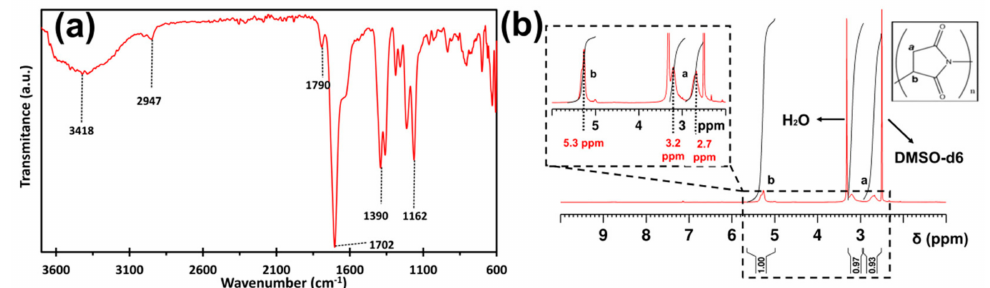
Figure 2. ( a ) FTIR and ( b ) 1 H NMR spectrum of PSI in DMSO- d 6